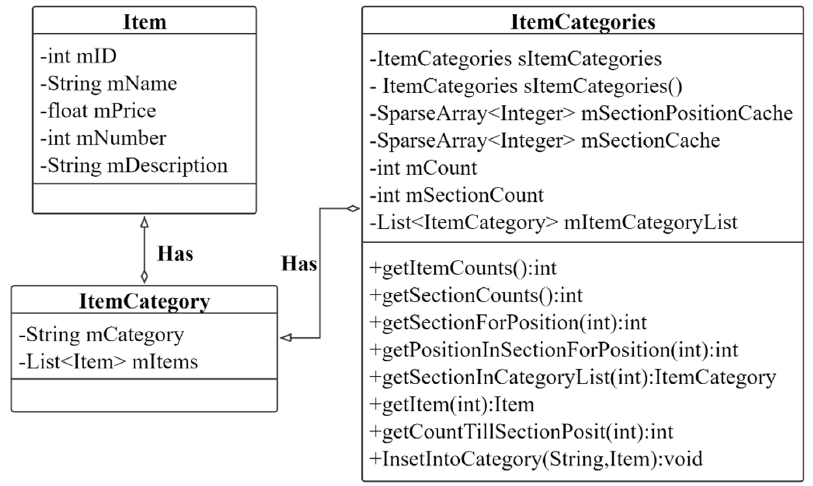
Figure 20. ItemCategories Class represents a list of categories including dishes and